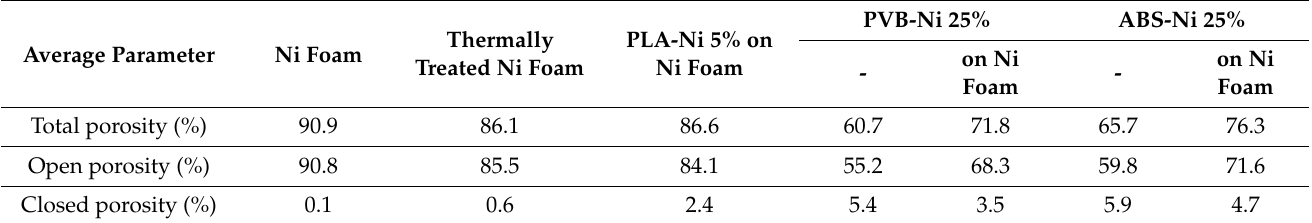
Table 5. Calculation results of porosity of nickel foam and final 3D